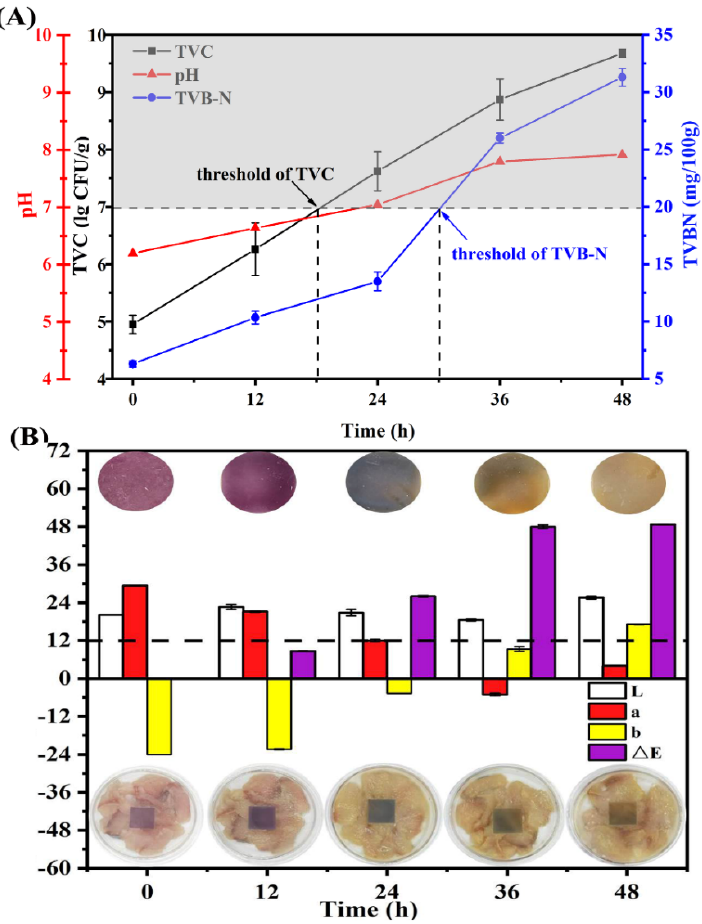
Figure 7. Changes in TVB − N, TVC, and pH values of fish ( A ) and the color response and parameters ( B ) of RCP/PVA film during storage at room temperature (25 °C).